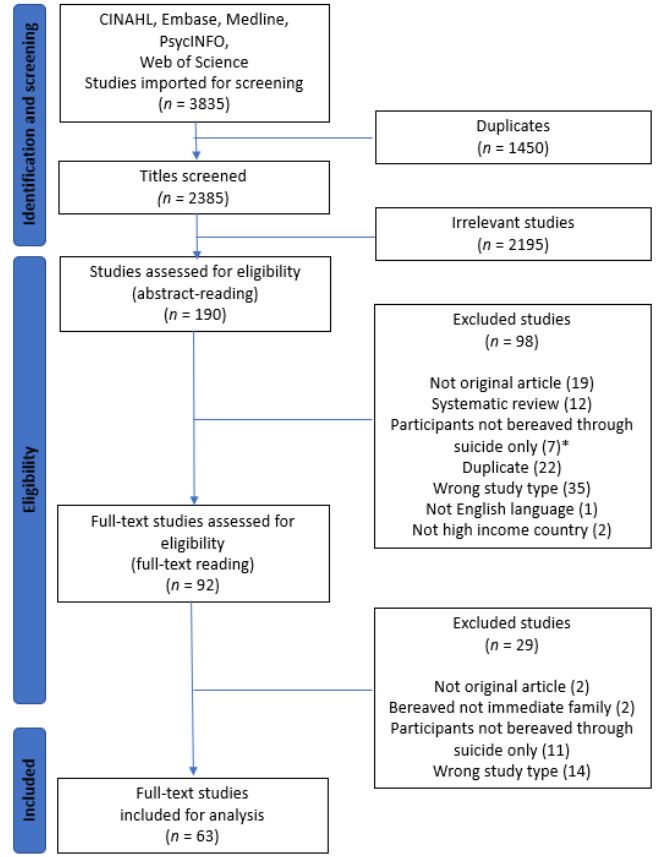
Figure 1. Search results—PRISMA diagram: Preferred Reporting Items for Systematic Reviews and Meta-Analyses. * Excluded if the results were not presented for the suicide bereaved separately.